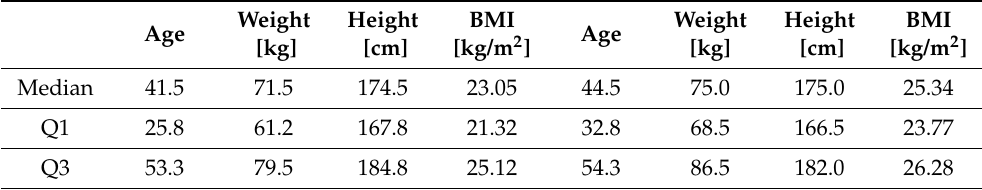
Table 1. Median, first (Q1) and third (Q3) quartiles of the Wearing Position Study (WPS, left side) and Simulated Hospital Study population (SHS, right side) characteristics: age, weight, height, and Body Mass Index